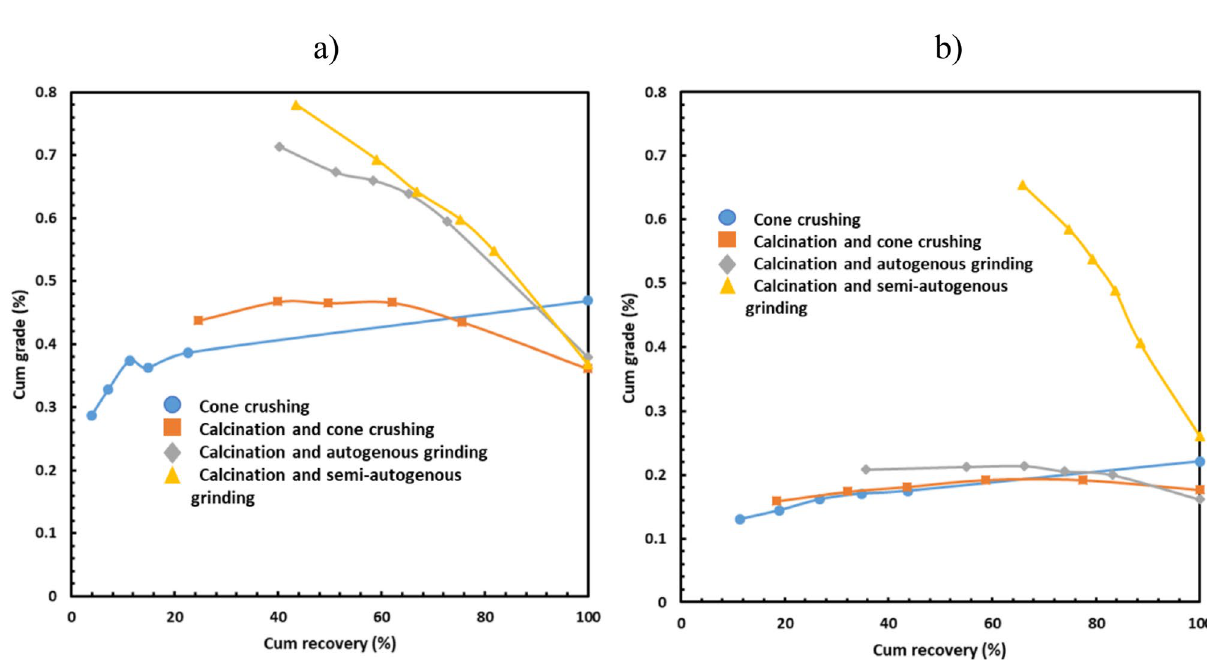
Figure 5. Cumulative grade vs cumulative recovery of lithium in the case of ( a ) TDMS and ( b )